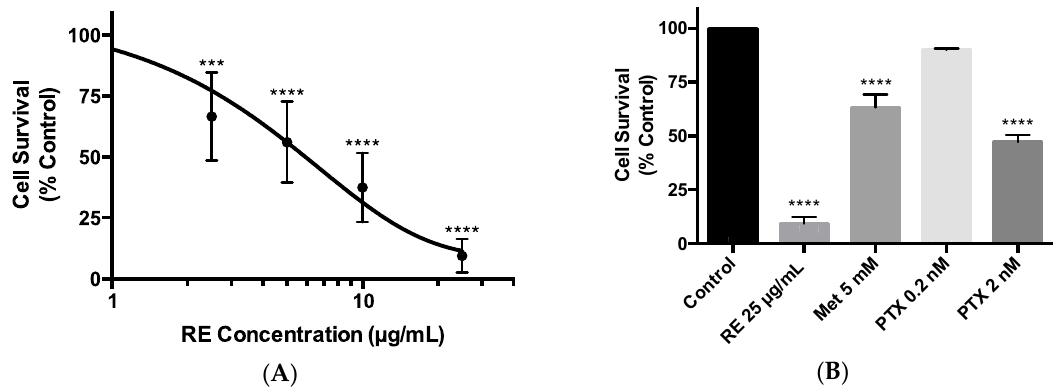
Figure 2. E ff ect of rosemary extract on MDA-MB-231 breast cancer cell survival. MDA-MB-231 cells were seeded (1000 cells / well) in six-well plates and exposed to 2.5, 5, 10, or 25 µ g / mL of rosemary extract (RE) ( A , B ), metformin (Met) ( B ), or paclitaxel (PTX) ( B ) for 7 days followed by fixing and staining with 0.05% methylene blue. Colonies of more than 50 cells were counted. Data are expressed as percent of control, untreated cells. Data are the mean ± SEM of six independent experiments. *** p < 0.001, **** p < 0.0001.